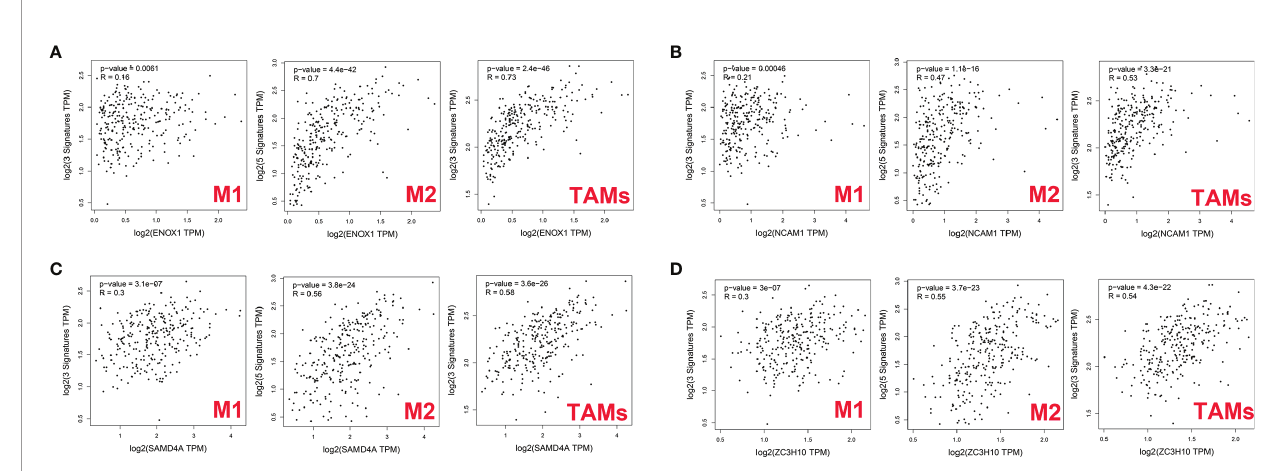
FIGURE 10 | Correlation between targeted gene expression levels and markers of macrophages as analysed via GEPIA2. (A) for ENOX1, (B) for NCAM1, (C) for SAMD4A, and (D) for